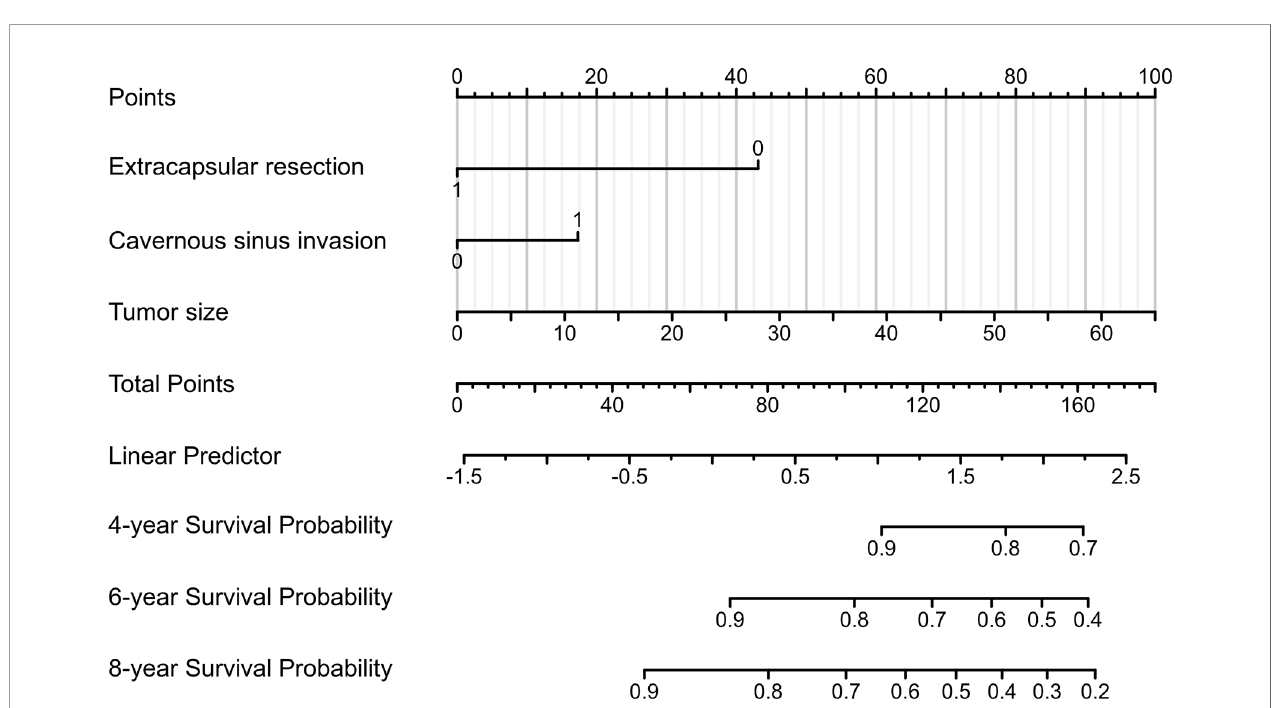
FIGURE 5 | A prognostic nomogram for predicting the 4-, 6-, and 8-year progression-free survival (PFS) probabilities in patients with pituitary adenomas (PAs) after gross-total resection (GTR).